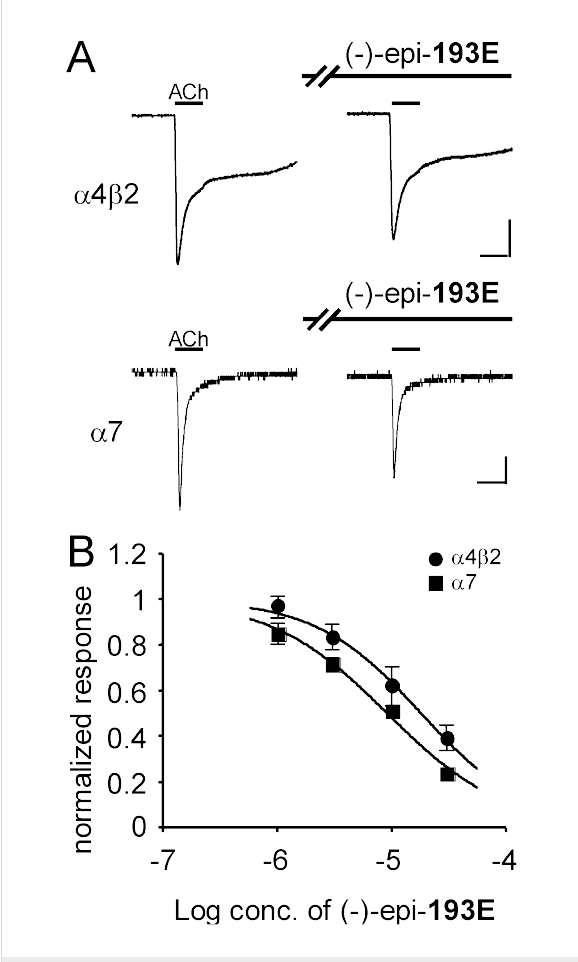
Figure 3: Inhibitory effect of (-)-epi- 193E on ACh-induced currents in X. laevis oocytes expressing recombinant nicotinic receptors. Currents were recorded in the voltage-clamp mode at -60 mV. Concentrations of ACh used were 1 μM for the α4β2 receptor and 100 μM for the α7 receptor. For test responses, oocytes were preincubated with (-)-epi- 193E for 3 min and then exposed to ACh with (-)-epi- 193E . A, repres- entative traces showing the ACh-elicited currents in the absence and presence of (-)-epi- 193E (3 μM). Horizontal bars indicate the period of perfusion with ACh for 5 s. Vertical scale bars represent 0.5 μA on the α4β2 receptor, and 0.1 μA on the α7 receptor. B, concentration- response curves for (-)-epi- 193E on recombinant nicotinic receptors. Current responses to ACh in the presence of (-)-epi- 193E in each oocyte were normalized to the ACh responses (control responses) recorded in the same oocytes. Values represent the mean ± S.E.M. for five separate